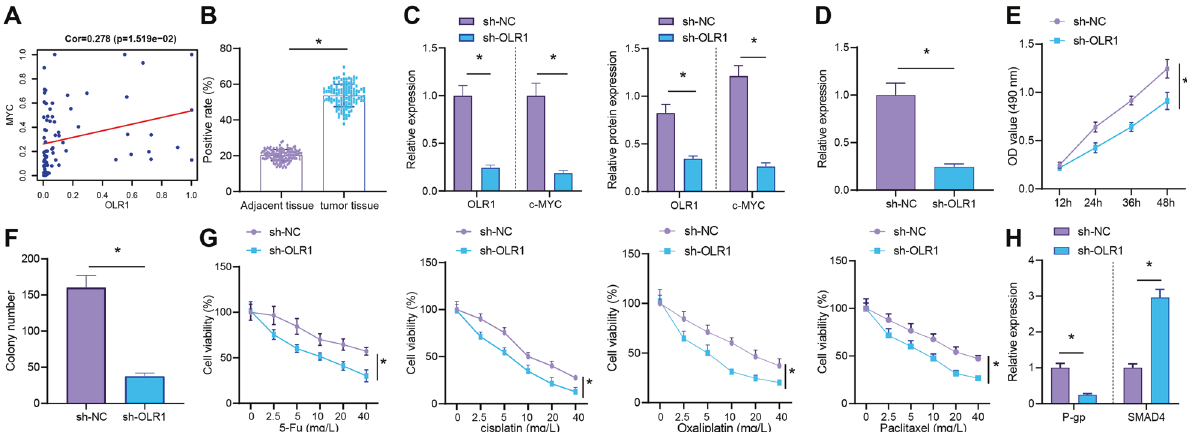
Fig. 2 OLR1 knockdown depresses c-MYC expression and the proliferation and chemoresistance of colon cancer cells. A Correlation map of expression data of OLR1 and c-MYC in GSE10950, GSE41328, and GSE75970. B Immunohistochemical staining to detect the expression of c-MYC protein in colon cancer tissues and adjacent normal tissues (adjacent tissues: n = 120; tumor tissues: n = 120). C RT-qPCR and western blot analysis to detect the expression of OLR1 and c-MYC in colon cancer cells. D Detection of Ki67 mRNA expression in colon cancer cells by RT-qPCR. E MTS to detect the proliferation of colon cancer cells. F Colony formation assay to detect the colony formation of colon cancer cells. G The drug resistance of colon cancer cells to DDP, oxaliplatin, 5-Fu, and paclitaxel detected by MTS. H RT-qPCR to detect the mRNA expression of P-gp and SMAD4 in colon cancer cells. The cell experiment was repeated three times. * p < 0.05 between two